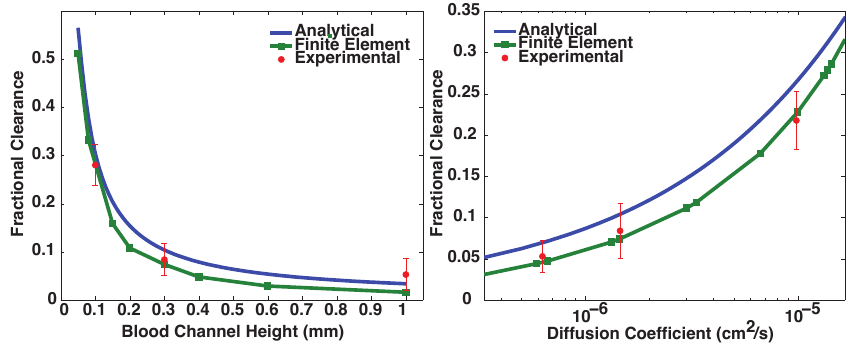
Figure 4. Comparison between the analytical model, the complex geometry finite element model, and experimental results. Experiments were performed with n = 3 or 4, and error bars represent standard error of the mean. Experiments varying blood channel height used solute with diffusion coefficient 1.6 × 10 − 6 and experiments varying diffusion coefficient used blood channel height of 0.3 mm. Residence time of blood channel fluid near the membrane was 10 s in all cases. The finite element model was highly predictive of experimental results, while the analytical model captured trends but systematically over-predicted clearance.